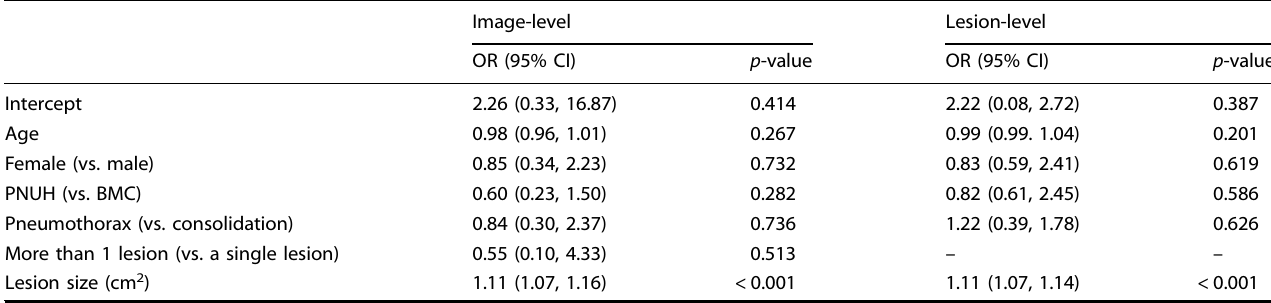
Table 3. Logistic regression results (image-level) and mixed effects logistic regression results (lesion-level) for associations between lesion characteristics and diagnostic accuracy of the CAD.